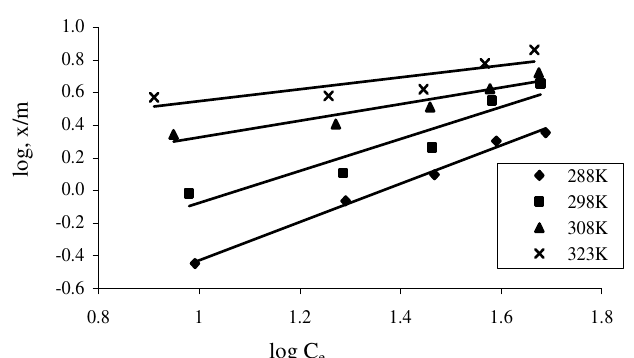
Figure 4. Freundlich isotherm for the adsorption of Pb 2+ by human hair